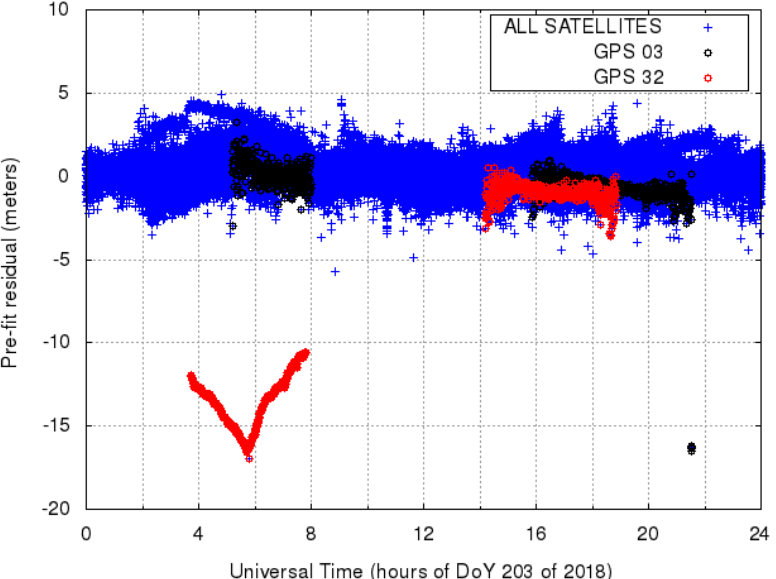
Figure 1. Raw actual pre-fit residuals recorded by station KIR0 on 4 November 2018. The pre-fit residuals for all satellites are depicted in blue color, while pre-fit residuals for GPS satellites 3 and 32 are depicted in red and black, respectively, to highlight some